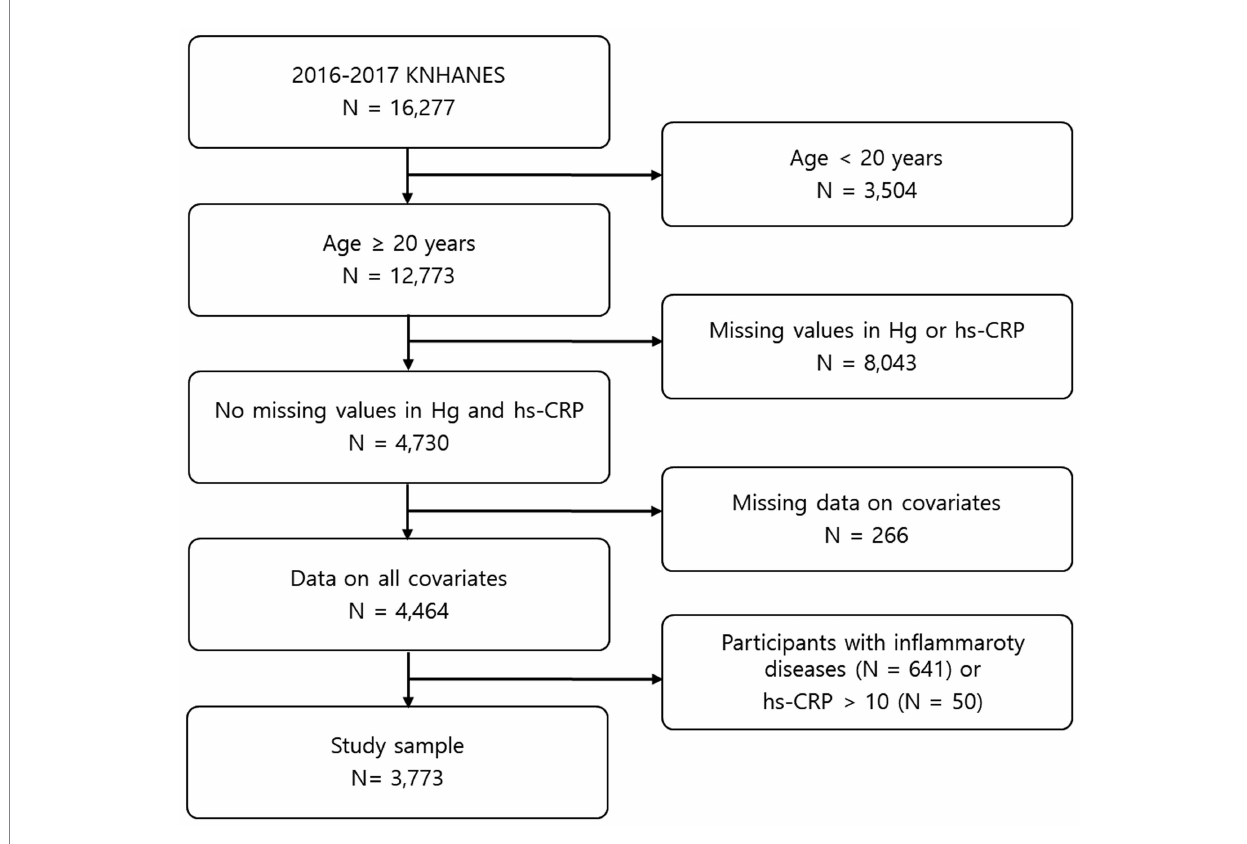
FIGURE 1 Flow chart of study sample